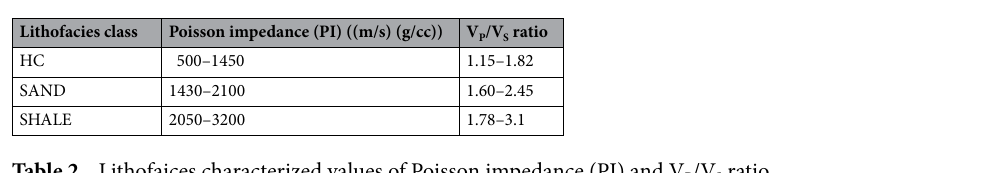
Table 2. Lithofaices characterized values of Poisson impedance (PI) and V P /V S